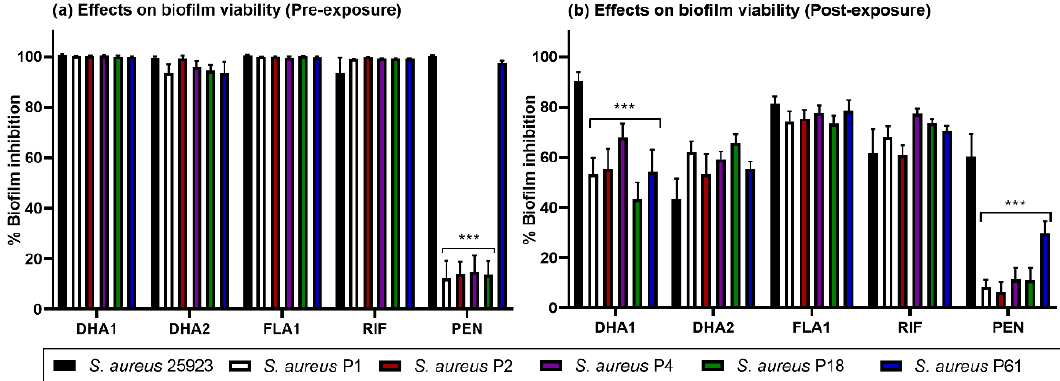
Figure 2. Effect of the two dehydroabietic acid (DHA) derivatives ( DHA1 and DHA2 ), the flavonoid-derivative ( FLA1 ), and two control antibiotics ( RIF and PEN ), at a concentration of 50 µM, when exposed before biofilm are formed ( a ) or on pre-formed S. aureus biofilms ( b ). Biofilms formed by one collection strain (ATCC 25923) and 5 different clinical isolates were tested. Statistical differences are indicated in comparison to the collection strain, *** p < 0.001. Results are expressed as mean ± SEM of three technical replicates in experiments repeated three times.